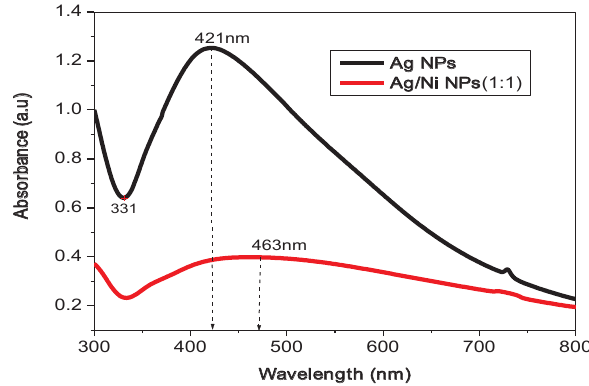
Figure 2: UV-Visible absorption spectra of mono and bi-metallic nanoparticles using Z. root extract.